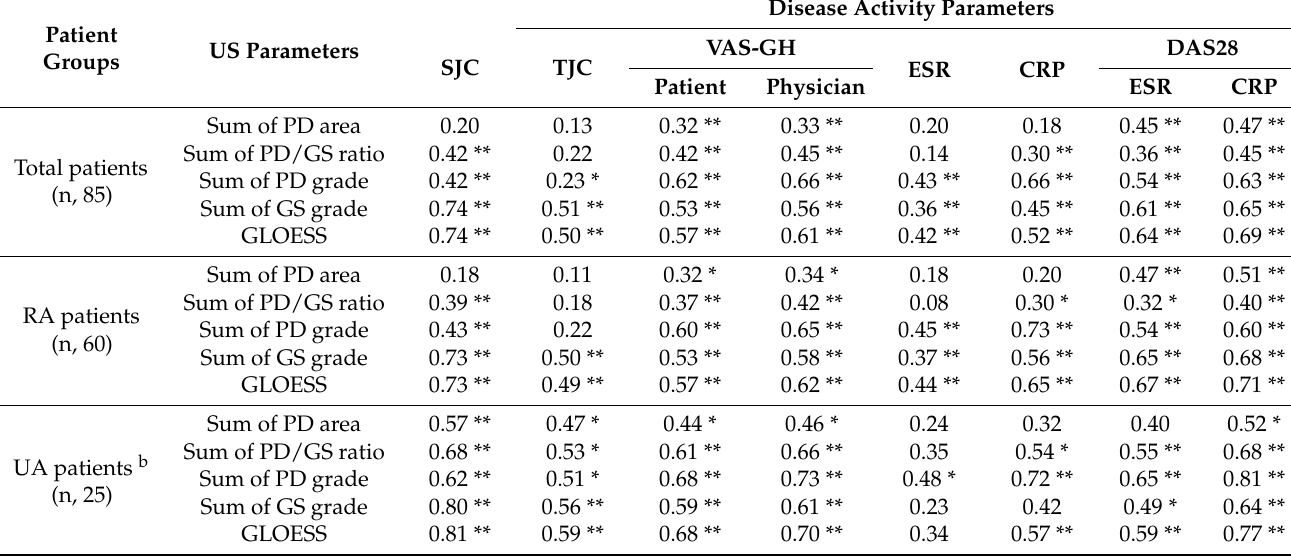
Table 4. Correlations between musculoskeletal ultrasonography parameters and clinical disease activity markers a . Patient